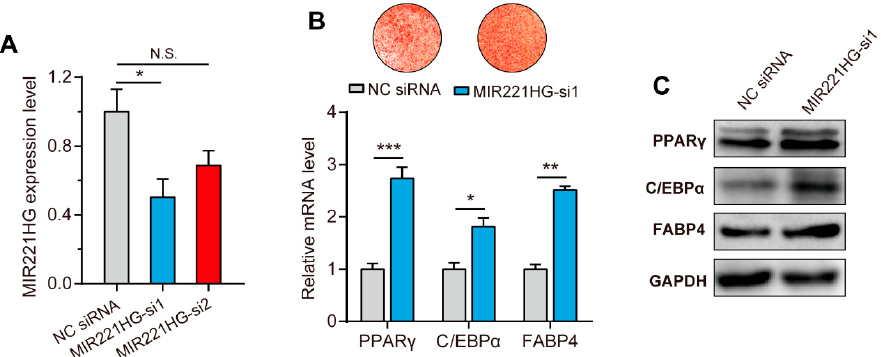
Figure 4. MIR221HG is a nucleus lncRNA. ( A , B ) MIR221HG in cytoplasmic (Cyto) and nuclear (Nuc) fractions of preadipocytes and adipocytes was determined by semi-quantitative PCR ( A ) and qRT-PCR ( B ). Glyceraldehyde-3-phosphate dehydrogenase (GAPDH) was used as markers for the cytoplasmic fraction. The data are representatives of three independent